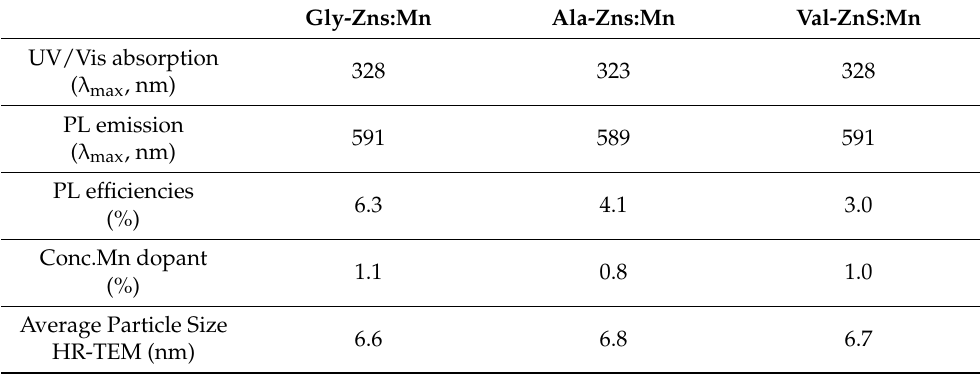
Table 1. Data summary of the amino-acid-capped ZnS:Mn